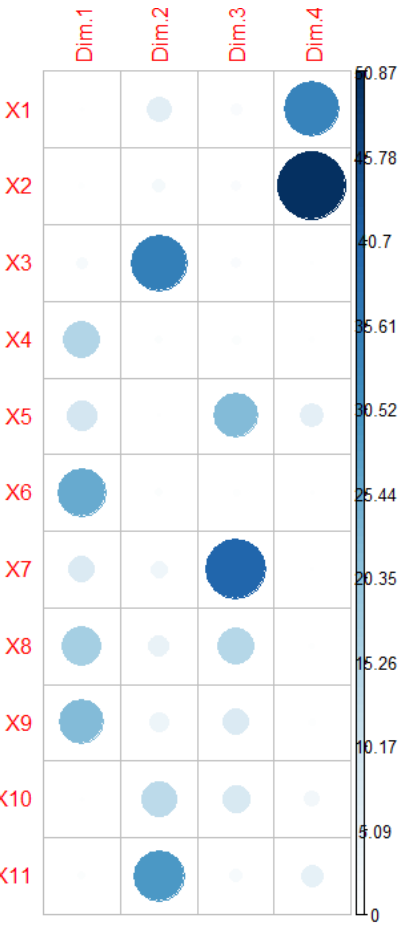
Figure 3. The principal component factor contribution graph. Dim1, DIM2, Dim3, and Dim4 represent four principal components. The larger circle area in the graph, the greater factor interpretation. Slope (X1), soil thickness (X2), altitude (X3), average age (X4), canopy (X5), average DBH (X6), number of plants per hectare (X7), volume per hectare (X8), average tree height (X9), ridge distance (X10), and river distance